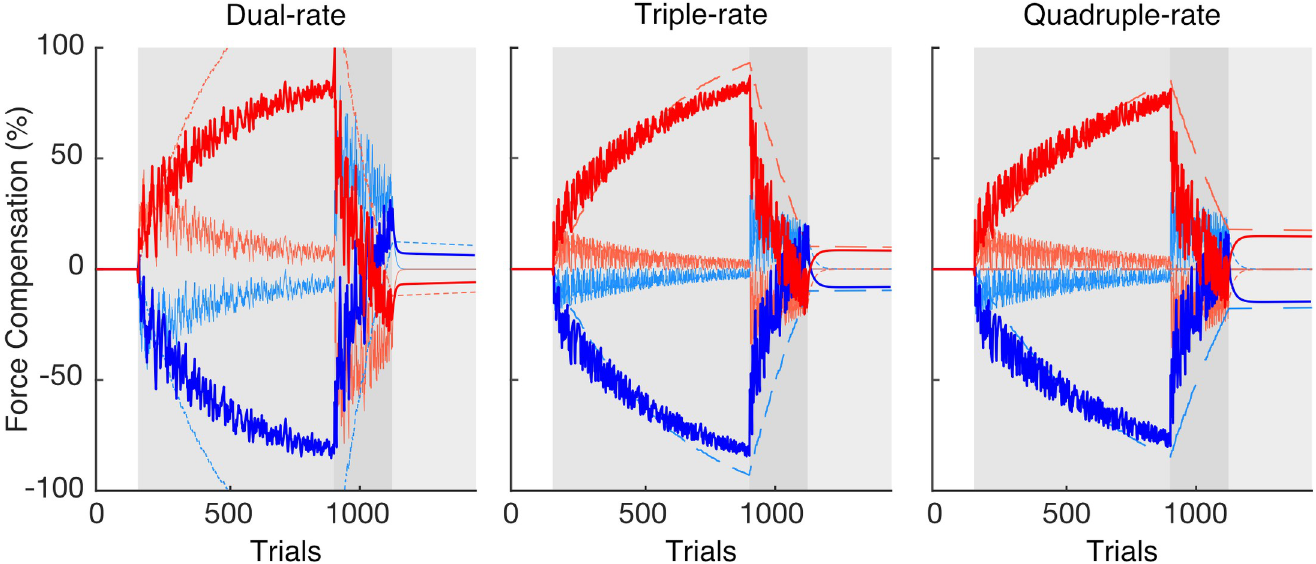
Fig 10. Simulation of best-fit set of parameters (median across participants) for the dual, triple and quadruple-rate models with two fast processes and a weighted switch. Here, the de-adaptation phase contained 220 trials (intermediate between experiment 1 and 2). The total output for each contextual cue (dark red and dark blue lines) is composed of the summation of each process (light red and light blue lines): hyperslow (long dashed), ultraslow (medium dashed), slow (dotted) and fast (solid) processes. Note that spontaneous recovery is revealed for both contextual cues in the error-clamp phase for triple and quadruple-rate models.